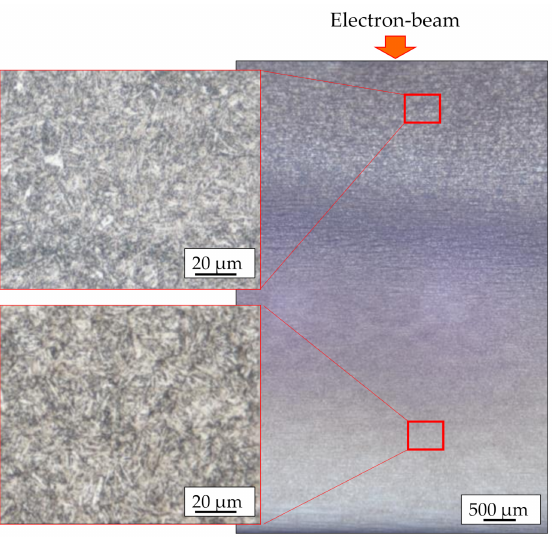
1000 ◦ C/10 s. The cross-sections were etched with an alcoholic nitric acid and analyzed with an optical microscope. It shows a fine-grained martensitic area with a local hardness increase (cf. red/orange-colored at 12 mm on y-axis in Figure 5) and some annealing effects (annealed martensite with many carbides) in the lower region (cf. light-blue-colored at 2 mm on y-axis in Figure 5).